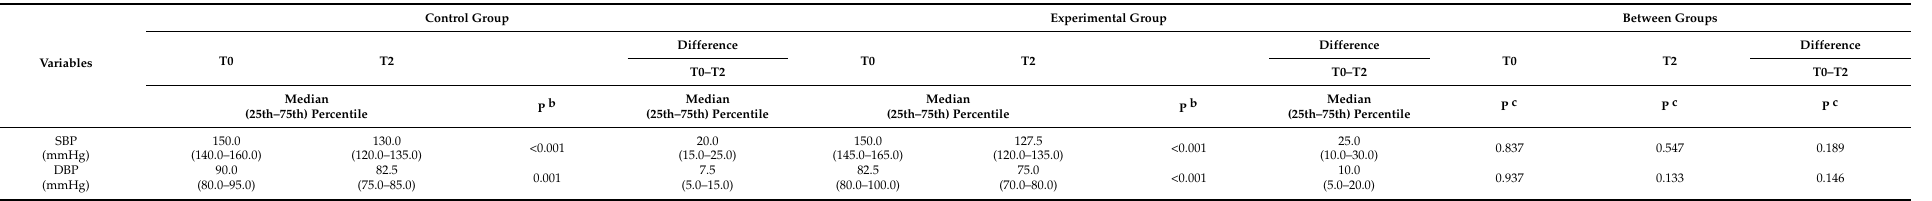
Table 3. Changes in patients’ blood pressure during the trial, and comparison between groups.